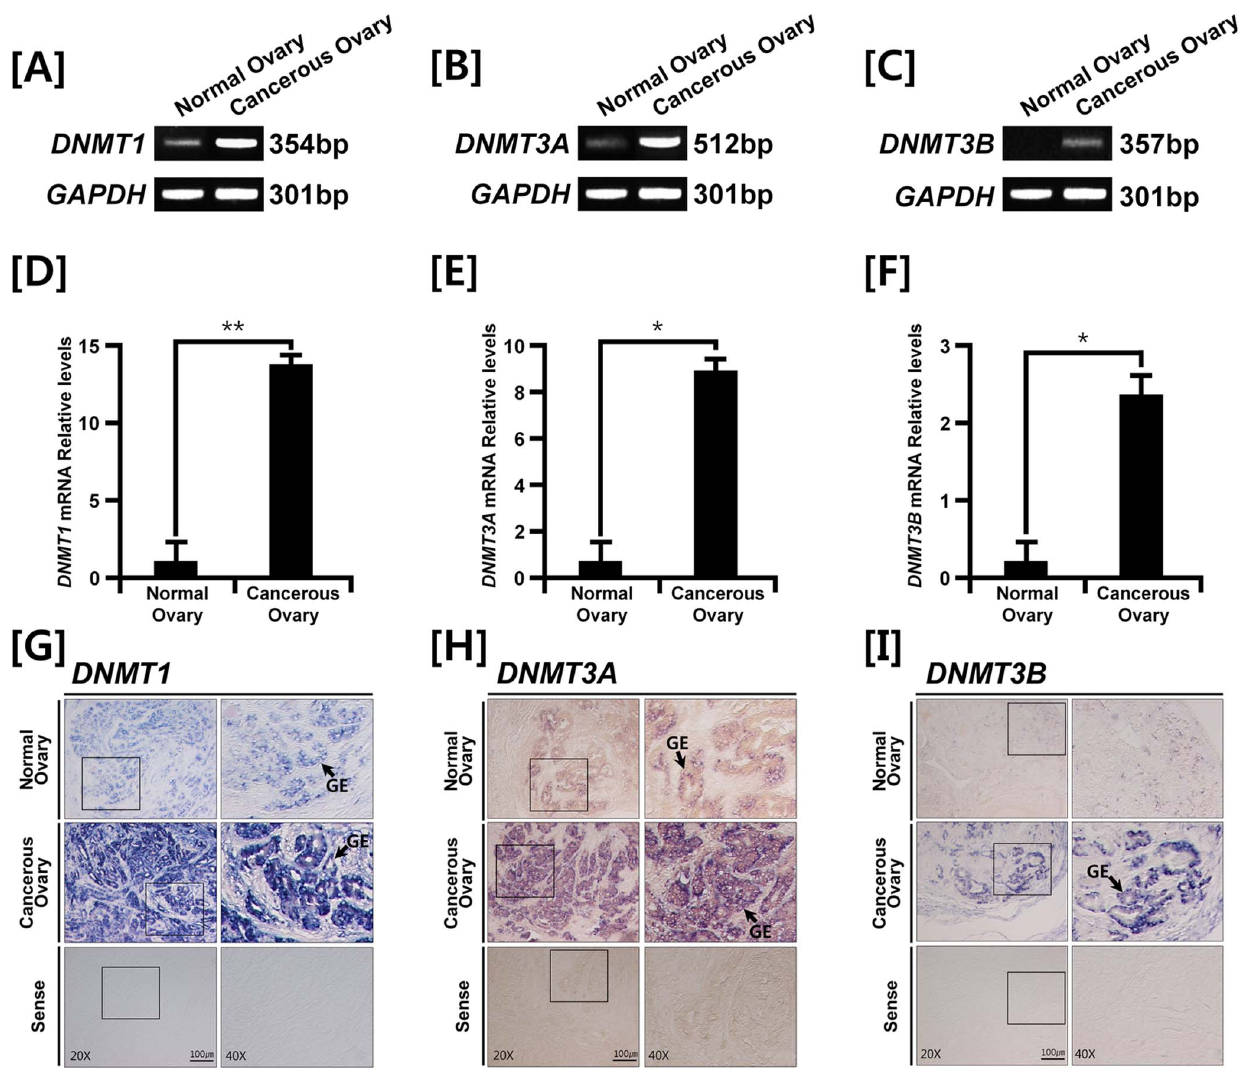
Figure 1. Expression, quantitation and localization of DNMTs in normal and cancerous ovaries from laying hens. [A–C] RT-PCR and [D– F] q-PCR analyses were performed using cDNA templates from normal and cancerous ovaries of laying hens using chicken DNMT1, DNMT3A, DNMT3B and GAPDH primers. The asterisks denote statistically significant differences (** P , 0.01 and * P , 0.05). [G–I] In situ hybridization analyses of DNMT mRNAs in normal and cancerous ovaries of hens. Cross-sections of normal and cancerous ovaries of hens hybridized with antisense or sense chicken DNMT cRNA probes. Legend: GE, glandular epithelium. See Materials and Methods for a complete description of the methods.